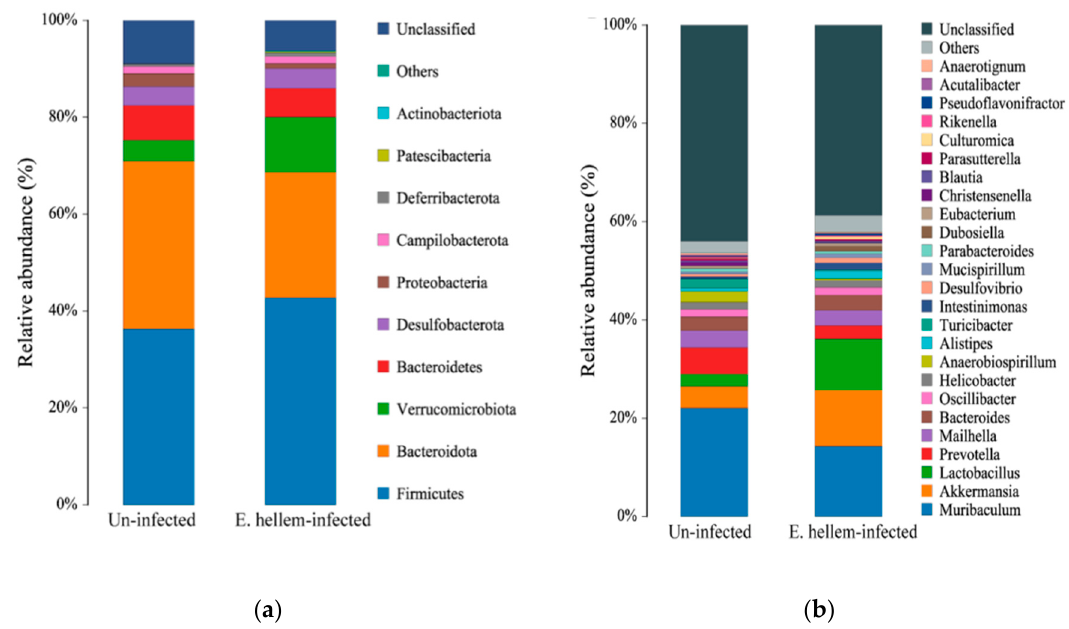
Figure 6. Composition of the gut bacteria in E. hellem -infected and uninfected group. The relative abundance of phylum-level ( a ) and genus-level ( b ) gut bacteria taxa were analyzed and showed in figure. The results showed E. hellem infection greatly changed the microbiota composition, both on phylum and genus levels.